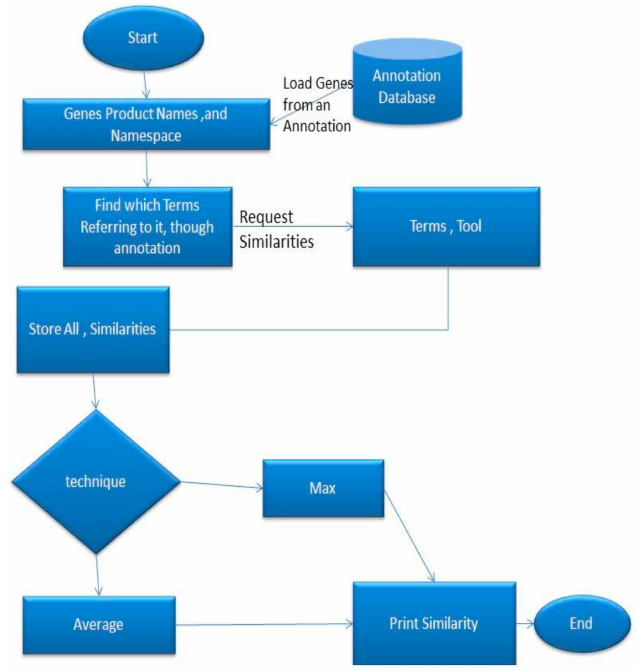
Figure 3. Translation of gene products to gene